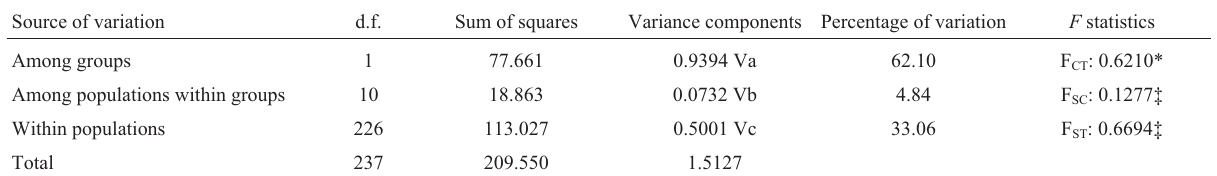
Table 4 - Spatial analysis of molecular variance (SAMOVA) between populations of Channa striata in Perak State. Significant values at p < 0.05 and p < 0.001 are indicated with * and ‡, respectively. Source of